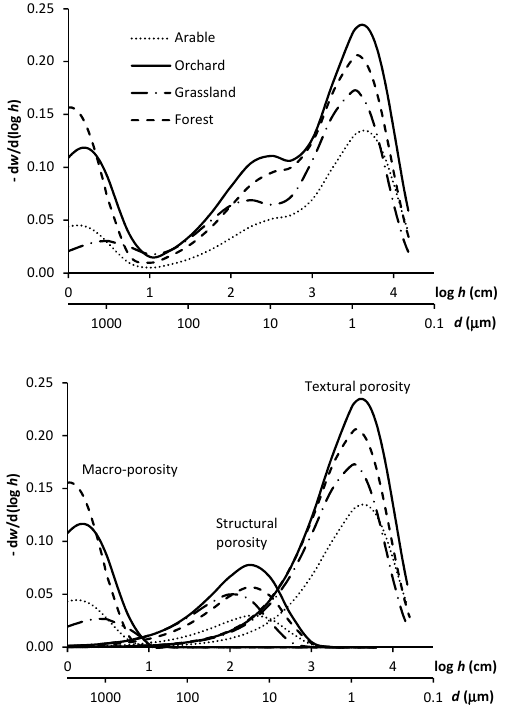
Figure 3. The pore size distribution (PSD) curves derived from the average SWRCs ( upper ) and de-convoluted peaks corresponding to the macro-, structural, and textural porosities ( lower ). The soil water retention properties derived from SWRCs have the same trend as the changes in the distribution of the three pore classes (Table 3). The AC is the highest in the orchard and forest research plots and the lowest in the arable plot, and the differences between the arable plot and the orchard and forest plots were significant at p < 0.01. The TP decreased in the orchard > forest > grassland > arable order, and the differences were statistically significant at p < 0.01, except between the grassland and arable plots and those in the forest and orchard. The AWC and FC decreased in the same order, with a non–significant difference between grassland and arable plots ( p > 0.05). Only the PWP decreased in a different order. The highest PWP value in the arable soil is attributed to the highest clay content at this research plot. The orchard plot also has a higher PWP value, most likely due to the highest SOC content, and the lowest PWP was found in the grassland with the lowest SOC content. The differences in PWP were significant at p < 0.05, except between the orchard and arable plots and those in the forest and grassland. Table 3. Water retention properties of soils at the four research plots.